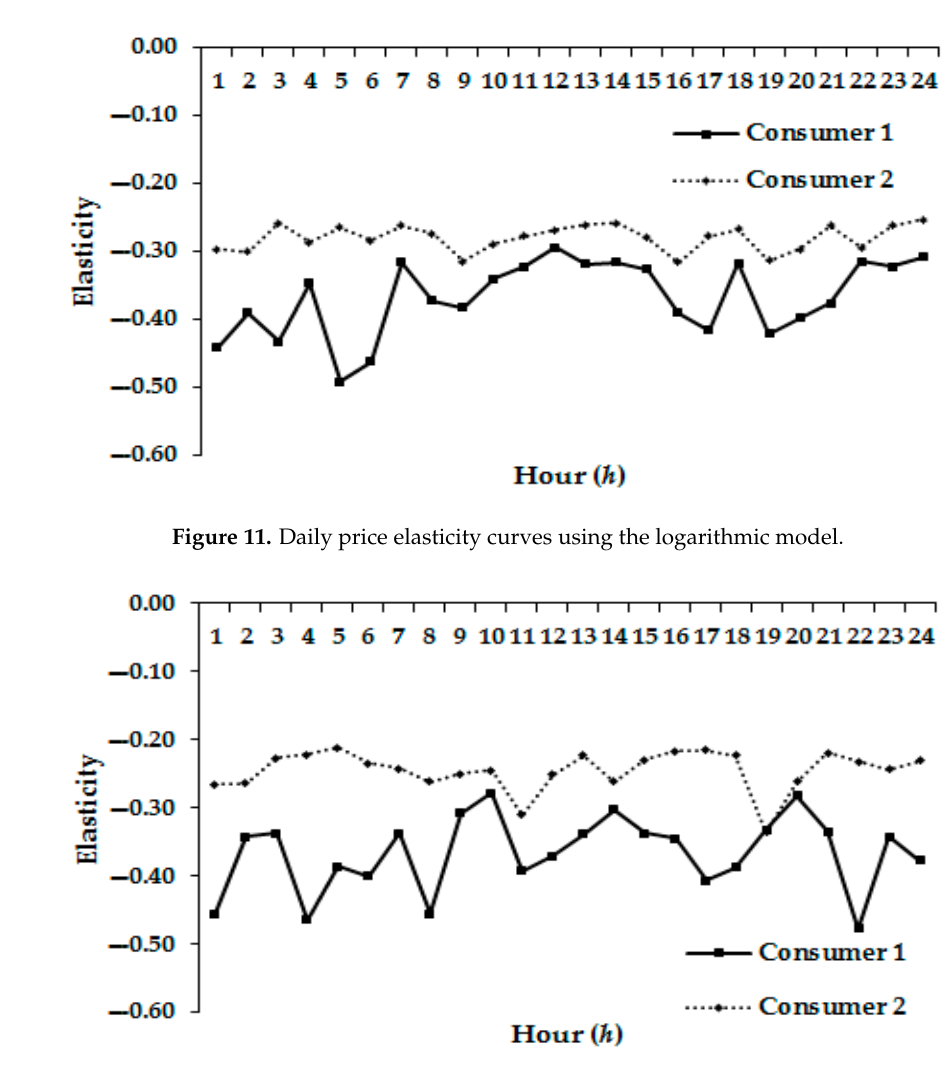
Figure 10. Daily price elasticity curves using the linear model.